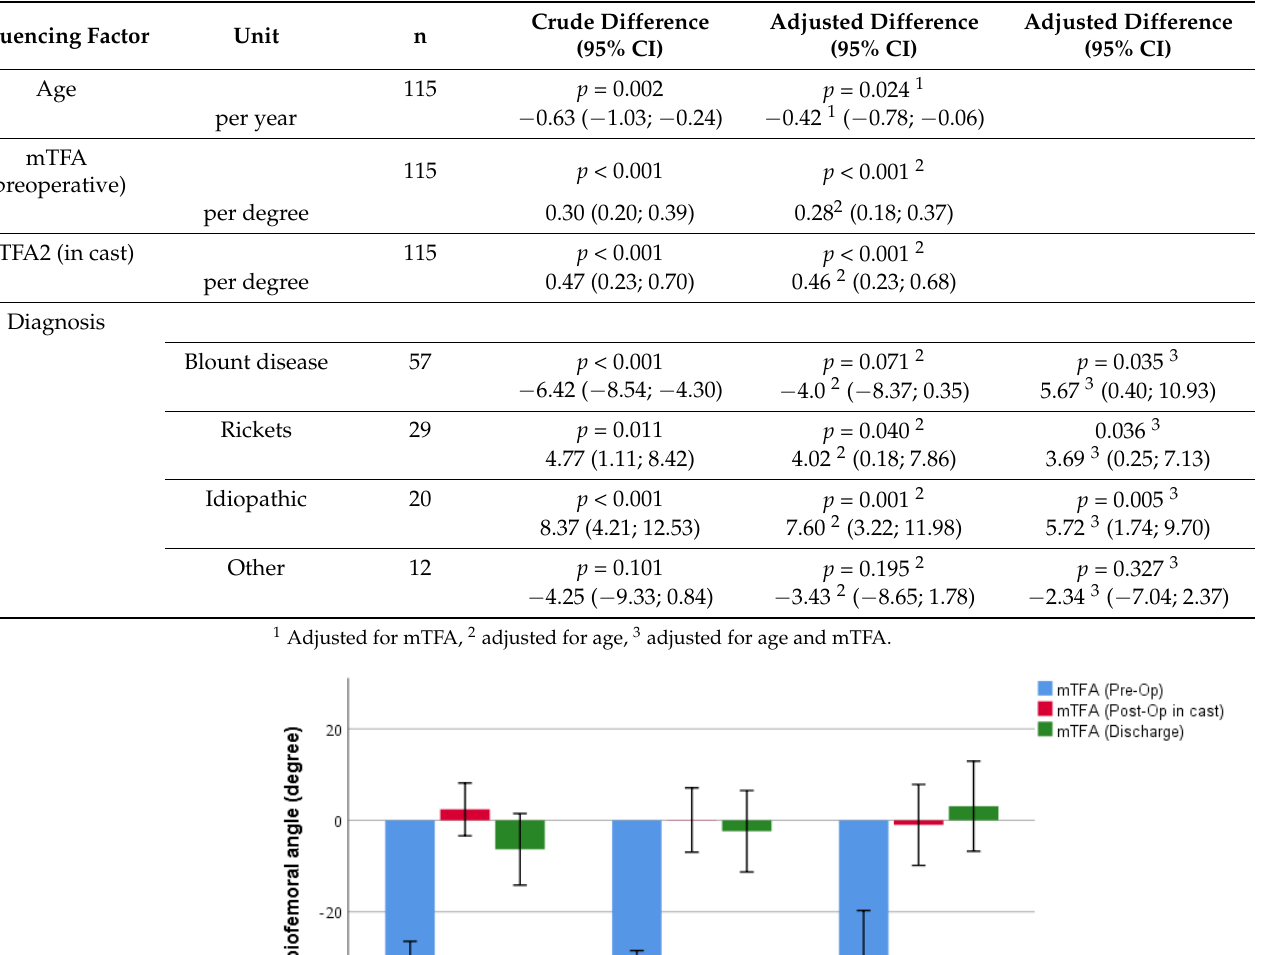
Table 2. Influencing factors on the mechanical tibiofemoral angle at discharge. Various possible factors were tested for their crude and their adjusted influence. Factors adjusted for are listed with the superscript numbers.